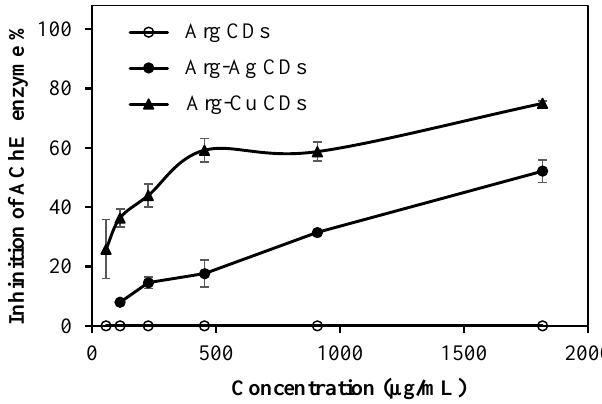
Figure 7. The inhibition of AChE enzyme activity % of Arg CDs, Arg-Ag CDs, and Arg-Cu CDs.